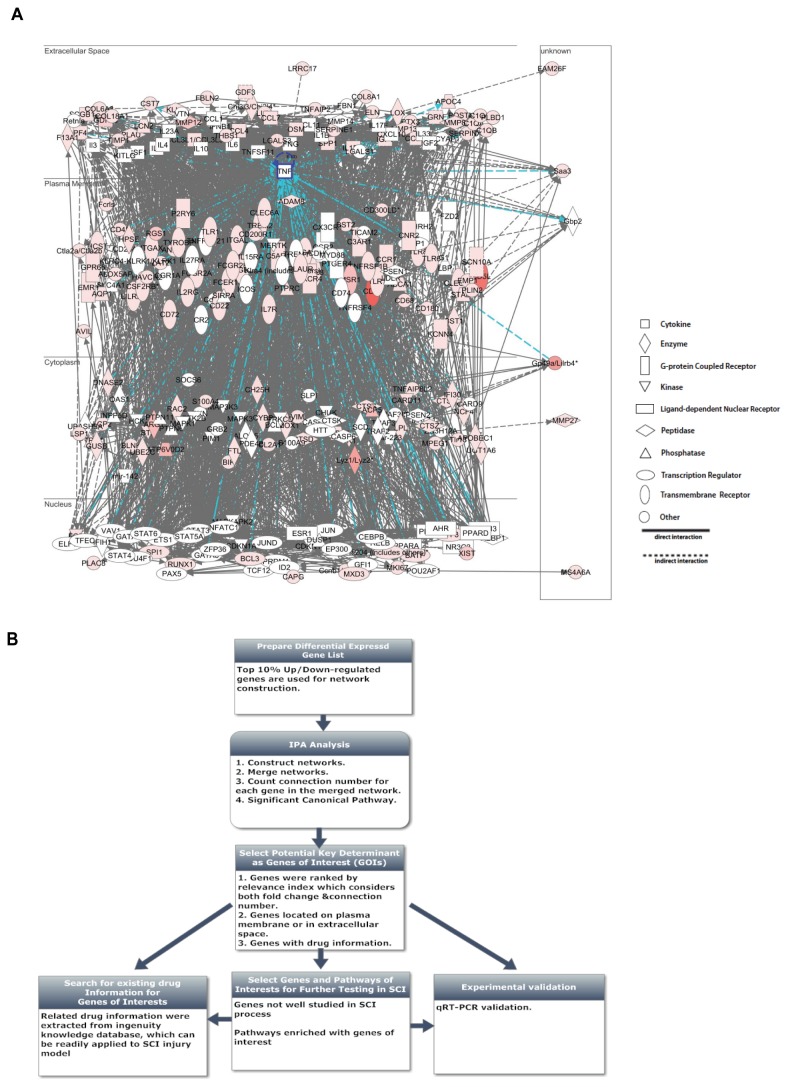
Developing a systems based analysis framework to identify key determinants in the global gene network.(A) Network constructed in 7D stage using top 10% up-regulated genes. Gene TNF (tumor necrosis factor) was highlighted with its connected edges (in blue). (B) The workflow of a systems based analysis framework in identifying potentially important genes.